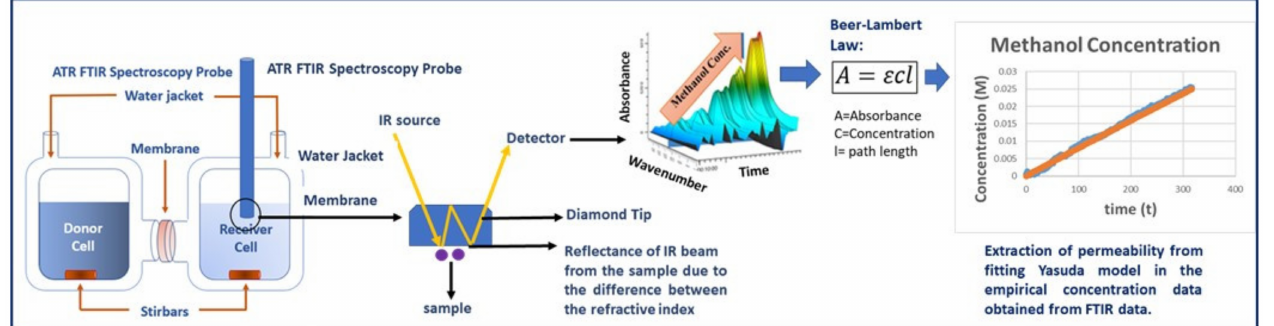
Figure 3. Schematic of multicomponent permeability measurement through the PEGDA-PEGMA membrane using a diffusion cell coupled with in situ ATR-FTIR spectroscopy [27]. Adapted in part from Ref.